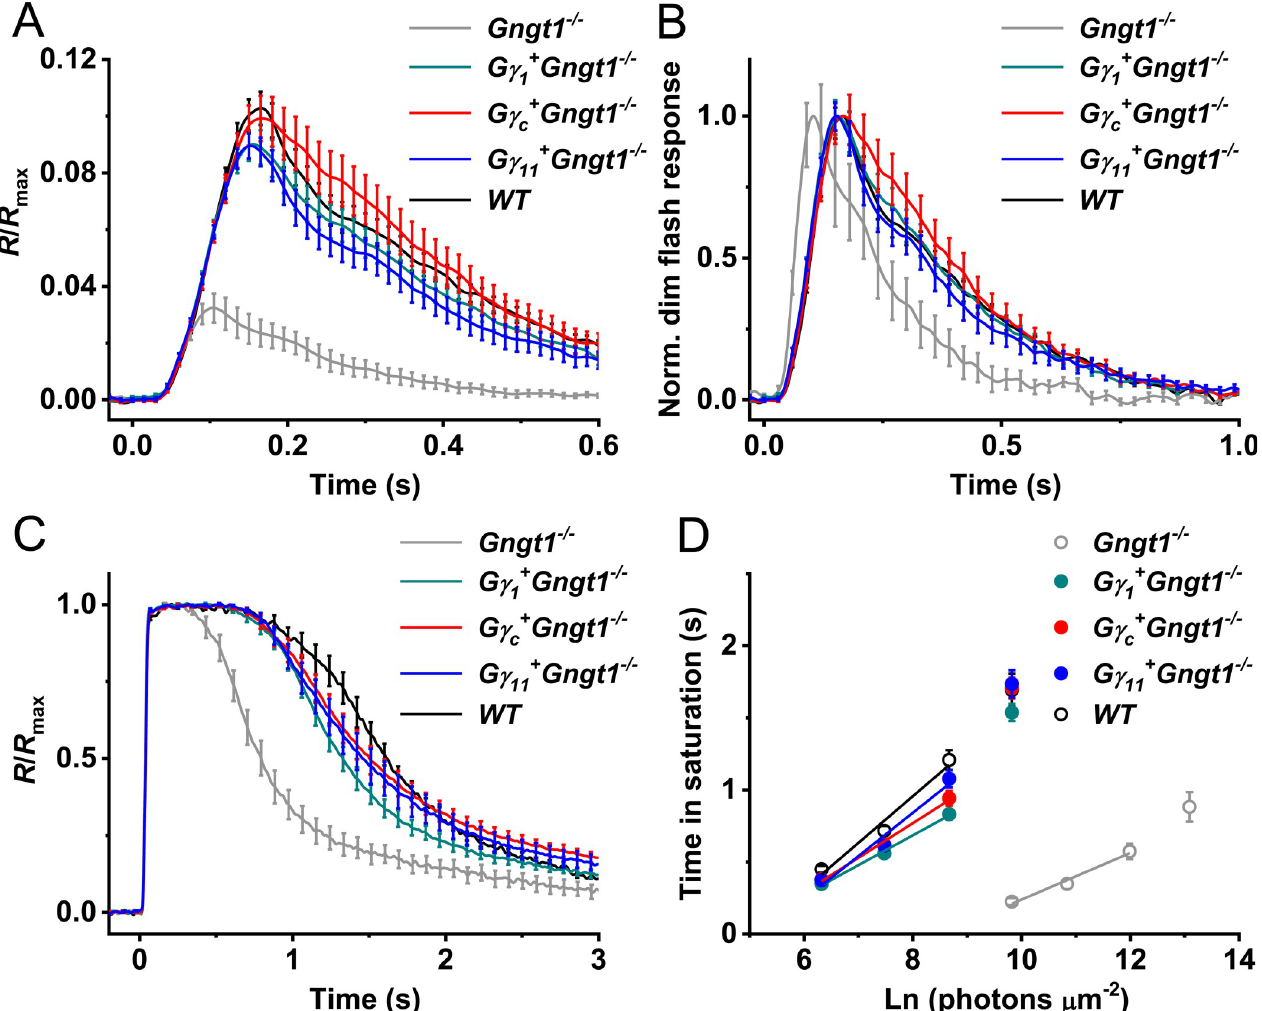
Fig 7. Activation and inactivation of rod phototransduction cascade in control and transgenic mice expressing different G γ subunits. ( A ) Amplification of phototransduction in mouse rods. Dim flash responses (to light intensities of 560 photons μ m -2 for Gngt1 -/- rods and 6 photons μ m -2 for wild type and all transgenic G γ -expressing rods) were normalized to maximum dark currents ( R max ) of the respective cells and population-averaged (mean ± SEM). Then, the Gngt1 -/- , G γ c+ Gngt1 -/- , and G γ 11+ Gngt1 -/- responses were scaled to make their initial rising phase to coincide with that of the wild type response. Correspondingly scaled light intensities were 0.03:1:0.9:1.1:1 ( Gngt1 -/- : G γ 1+ Gngt1 -/- : G γ c+ Gngt1 -/- : G γ 11+ Gngt1 -/- : WT ), indicating ~30-fold higher gain in the G γ - expressing rods. ( B ) Phototransduction shutoff in mouse rods. Dim flash responses (to light intensities of 560 photons μ m -2 for control Gngt1 -/- rods and 6 photons μ m -2 for wild type and all G γ -expressing rods) were normalized to their own maximums and population-averaged (mean ± SEM). ( C ) Supersaturated responses (to light intensities of 1.6x10 5 photons μ m -2 for control Gngt1 -/- rods and 5.8x10 3 photons μ m -2 for wild type and all G γ -expressing rods) were normalized to their amplitudes ( R max ) and population-averaged (mean ± SEM). ( D ) Determination of the dominant recovery time constant ( τ D ) from a series of supersaturating flashes for Gngt1 -/- (n = 11), G γ 1+ Gngt1 -/- (n = 31), G γ c+ Gngt1 -/- (n = 30), G γ 11+ Gngt1 -/- (n = 23), and wild type (n = 8) mouse rods. Linear fits yielded τ D -values indicated in Table 1. Values are means ± SEM (smaller than the symbol size for some data